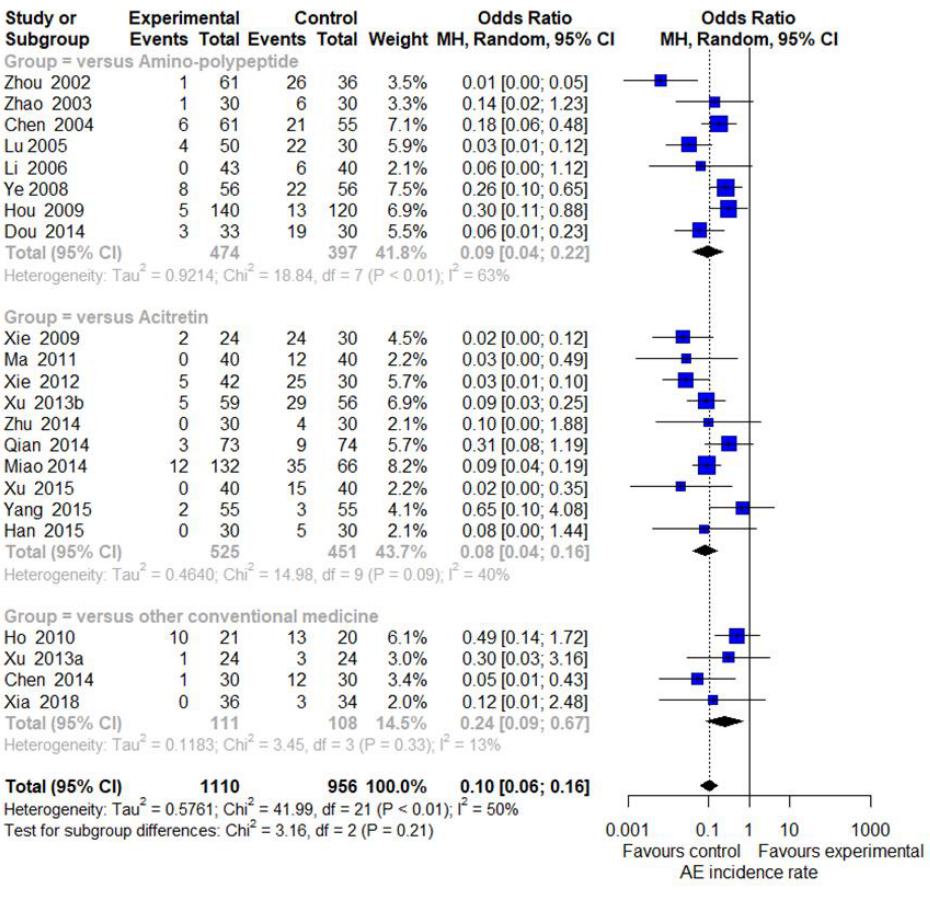
Figure 6. Forest plot for the incidence rates of reported adverse events.